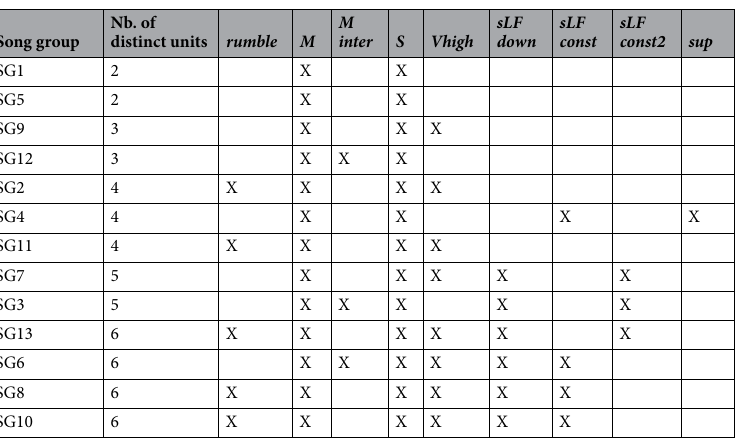
Table 1. Presence of unit types per song group. The order of the units in the table reflects the temporal arrangement of units composing the song groups. Presence marked with an x, absence with an empty